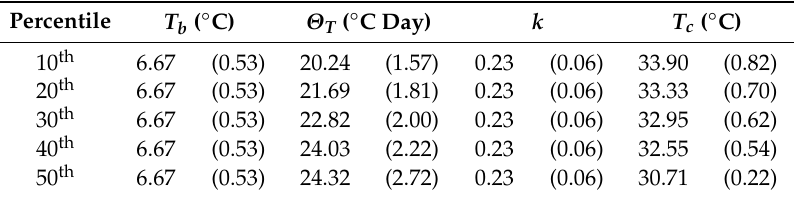
Table 3. Influence of temperature on the germination rates for Conyza canadensis for the di ff erent percentiles: parameter estimates for Equation (2). T b : base temperature, Θ T : thermal time for seed germination, k : shape parameter, T c : ceiling temperature. Standard errors are in parentheses. Percentile